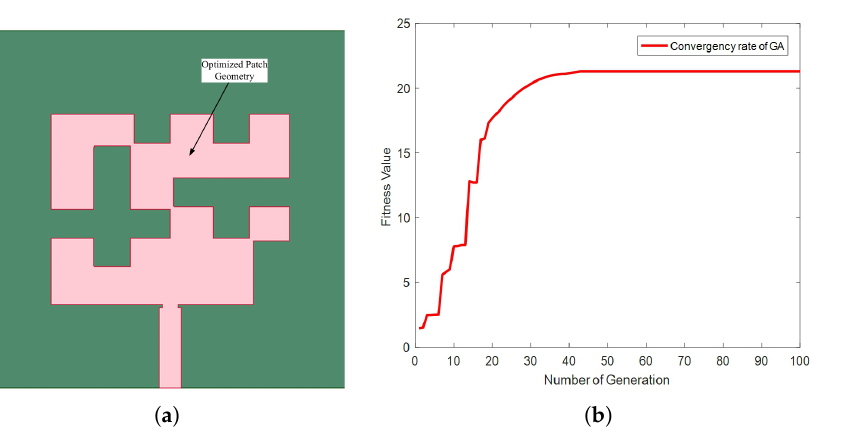
Figure 4. ( a ) Genetically optimized patch geometry, ( b ) average fitness value vs. number of generation.